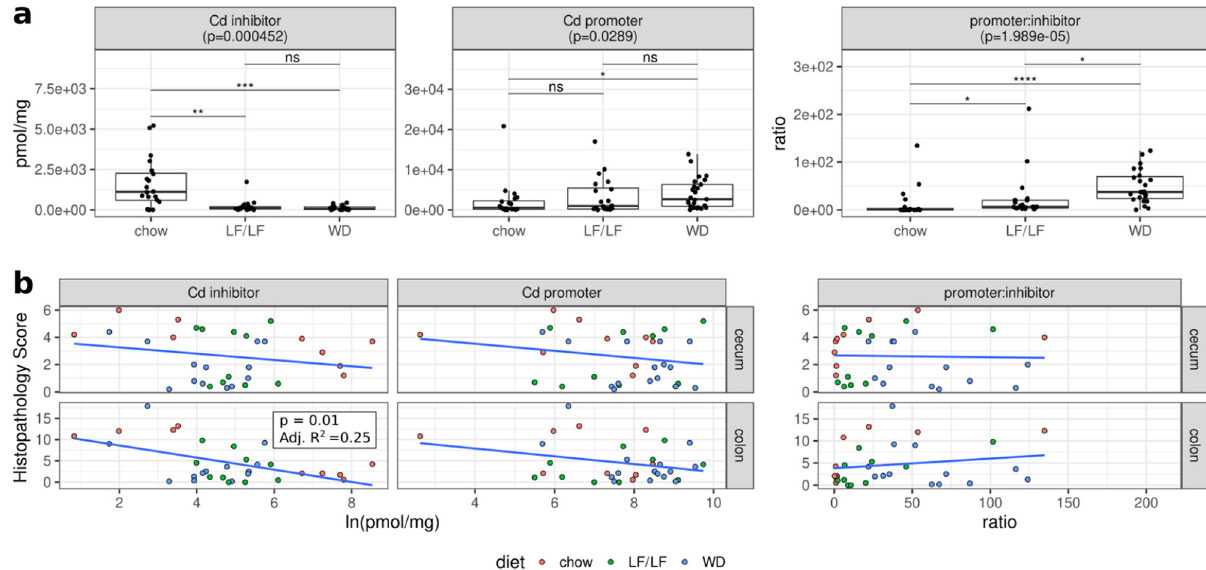
Fig. 3 Bile acid pools in cecal contents of infected mice 3 days post C. dif fi cile infection. a Cecal levels of C. dif fi cile inhibitors ( CDCA, UDCA, a_MCA, b_MCA, LCA, DCA) , C. dif fi cile promoters ( TCA , CA ), DCA, and ratios of promoters:inhibitors across diets (chow n ; = 20, LF n = 20, WD n = 26; Supplementary Table 2). Signi fi cant differences calculated with a Kruskal – Wallis and Dunn ’ s post hoc test. Kruskal – Wallis p -values were corrected for multiple comparisons with the FDR algorithm of Benjamini and Hochberg. Median and IQR indicated. (* p < 0.05, ** p < 0.01, *** p < 0.001, **** p < 0.0001). b Linear regressions of cecal or colonic histology against CD inhibitors, CD promoters, and the promoter:inhibitor ratios. Only colon in fl ammation versus C. dif fi cile inhibitors was signi fi